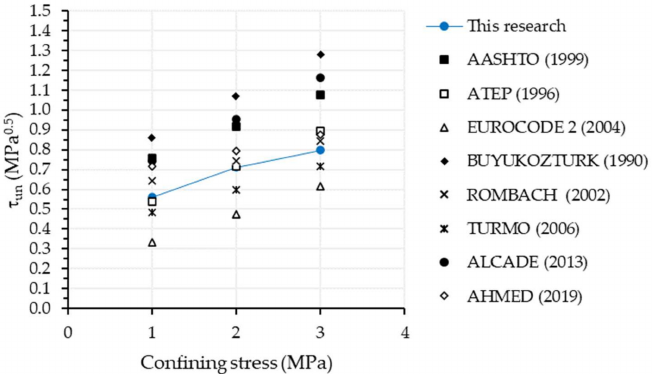
Figure 24. Experimental results and prediction of maximum normalized shear stress of the three- keyed RAC dry joints using the equations in the literature [13,18–24].